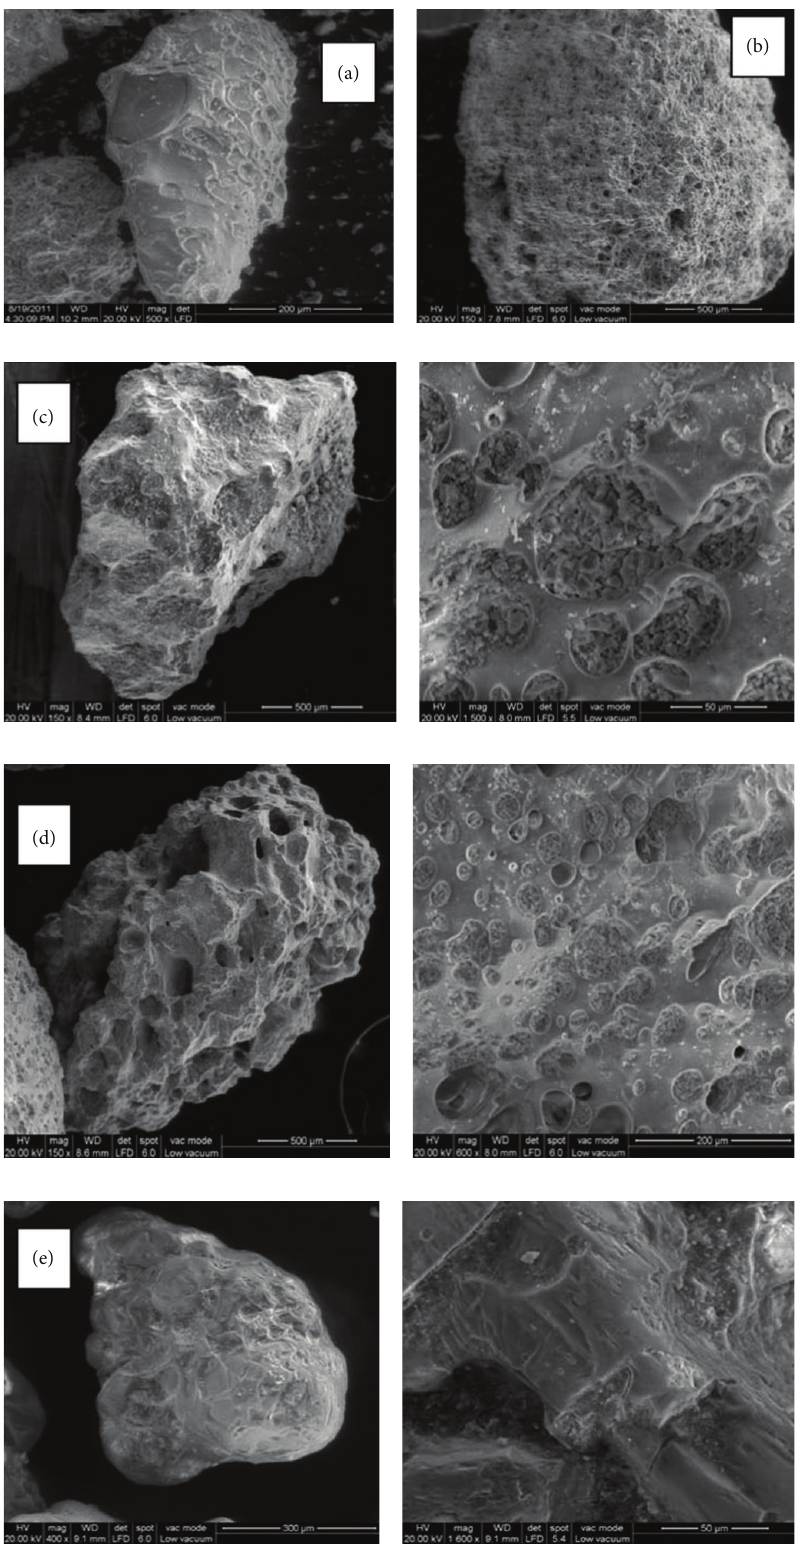
Figure 1: SEM micrographs of samples (a) PM, (b) PT, (c) ST, (d) ST W , and (e) RB. PM: volcanic pyroclastic mixture; PT: pumiceous type; ST: scoria type; ST W : washed scoria type; RB: rounded